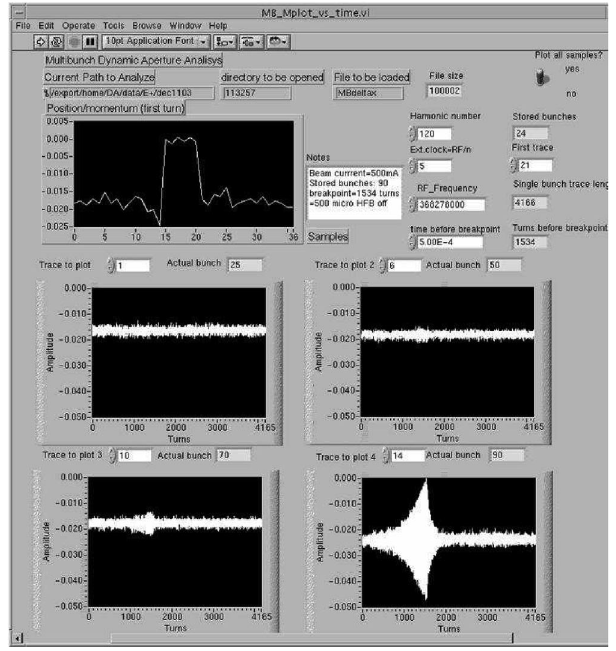
FIG. 32. Grow-damp measurement of horizontal oscillations for bunches 25, 50, 70, and 90 at DAFNE in 2004 [39]; the feedback was switched off for a short time; 90 bunches were followed by a gap of 30 missing